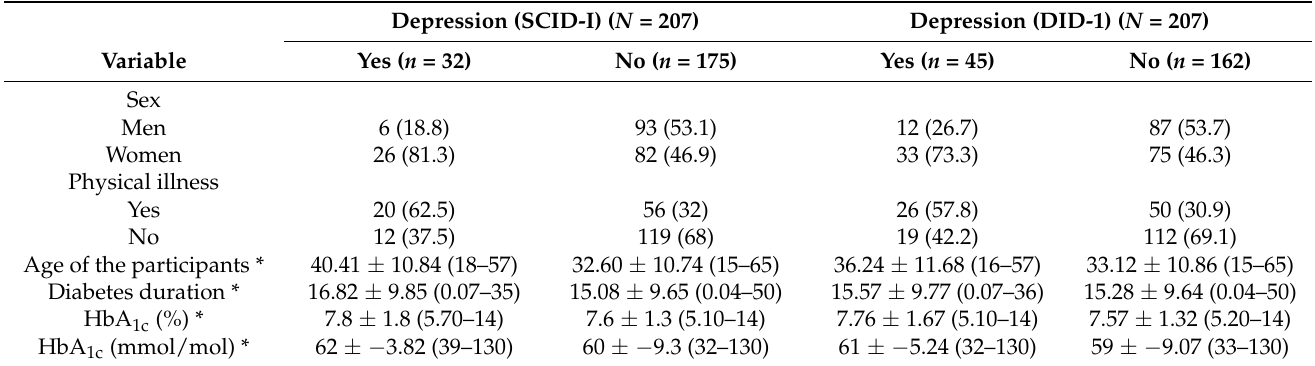
Table 1. Demographic characteristics of the total sample ( N = 207).